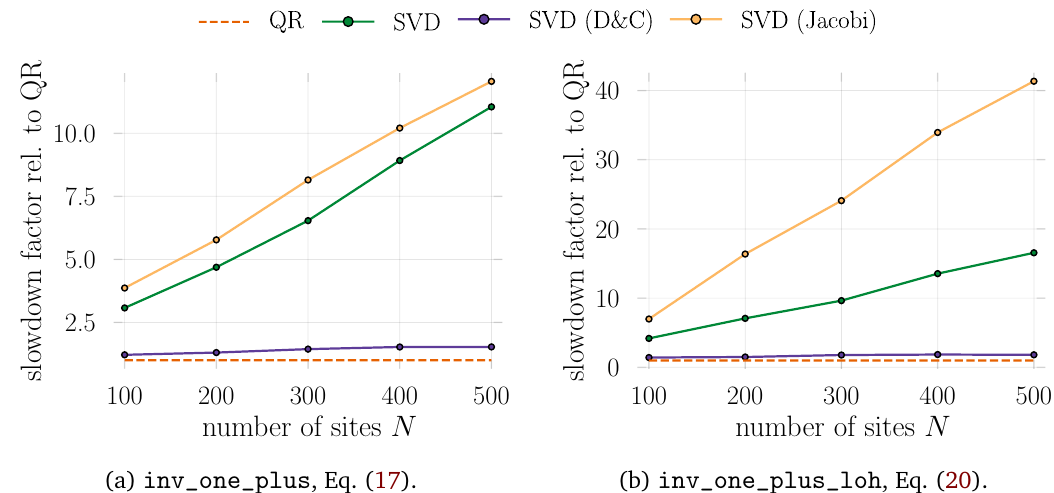
Figure (5) Efficiency of the stabilized Green’s function calculation using the listed matrix decompositions and inversion schemes. Shown are results for U =